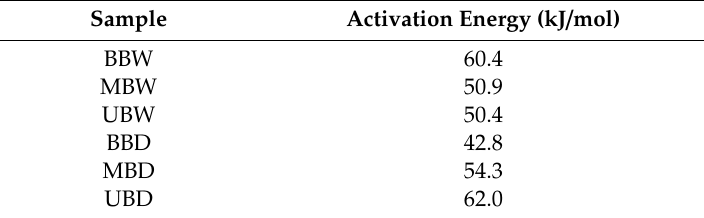
Table 6. Activation energy of the pyrolysis process of okra fibers (standard deviation 4.5%) calculated by the Coats-Redfern method.